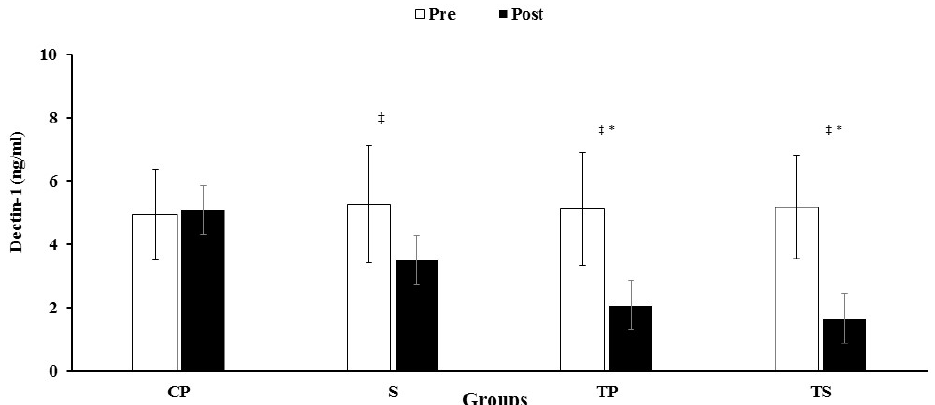
Figure 3. Pre and post training values (mean ± SD) for 3 Dectin-1. CP, Control–Placebo; S, Supplement; TP, Training–Placebo; TS, Training–Supplement groups. * indicates significant differences compared to the control group ( p < 0.05). ‡ indicated significant difference from baseline ( p < 0.05).